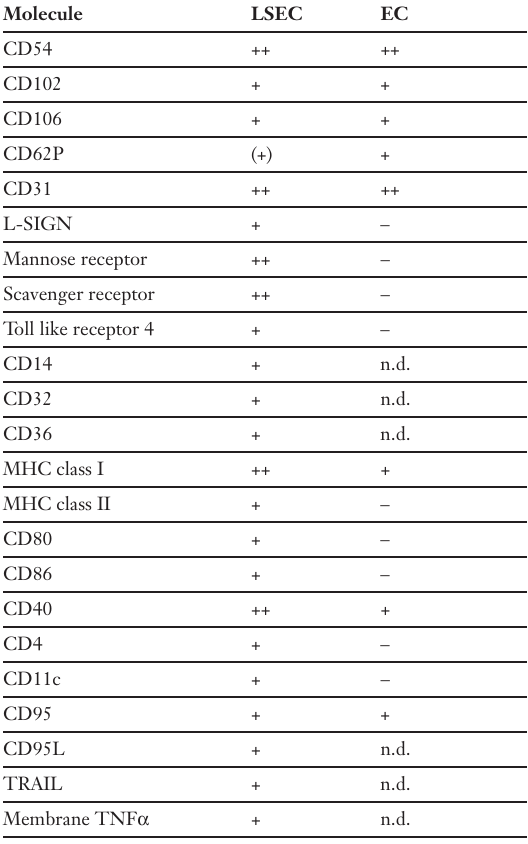
Phenotype of liver sinusoidal endo- thelial